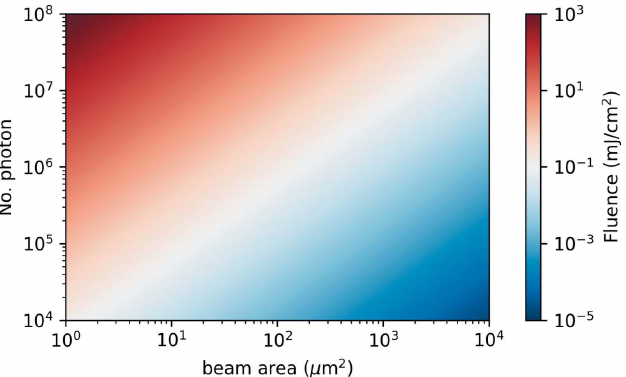
Figure 10 X-ray fluence on the sample, in mJ cm (cid:2) 2 , as a function of the beam size and the number of 1 keV photons in the beam. A limit of 0.1 mJ cm (cid:2) 2 , ensuring negligible non-linear X-ray absorption effects, is shown as white color. Values below and above this limit are shown in blue and red,